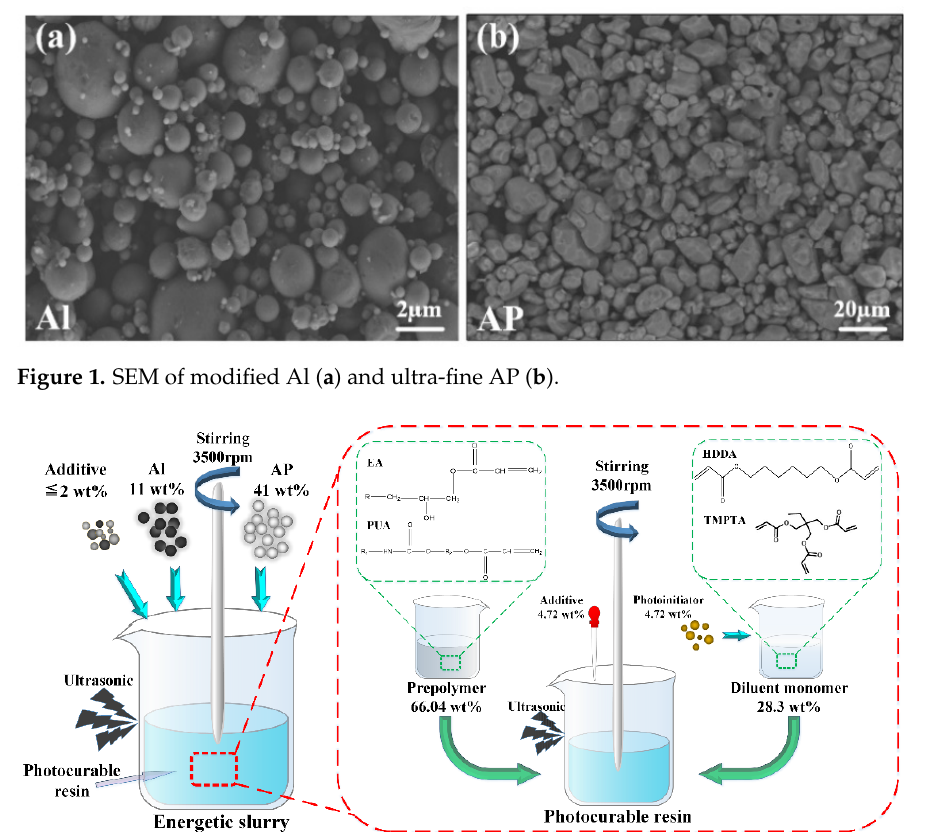
Figure 2. The preparation process of photocurable resin and the energetic slurry. Table 1. The formula of photocurable resin.